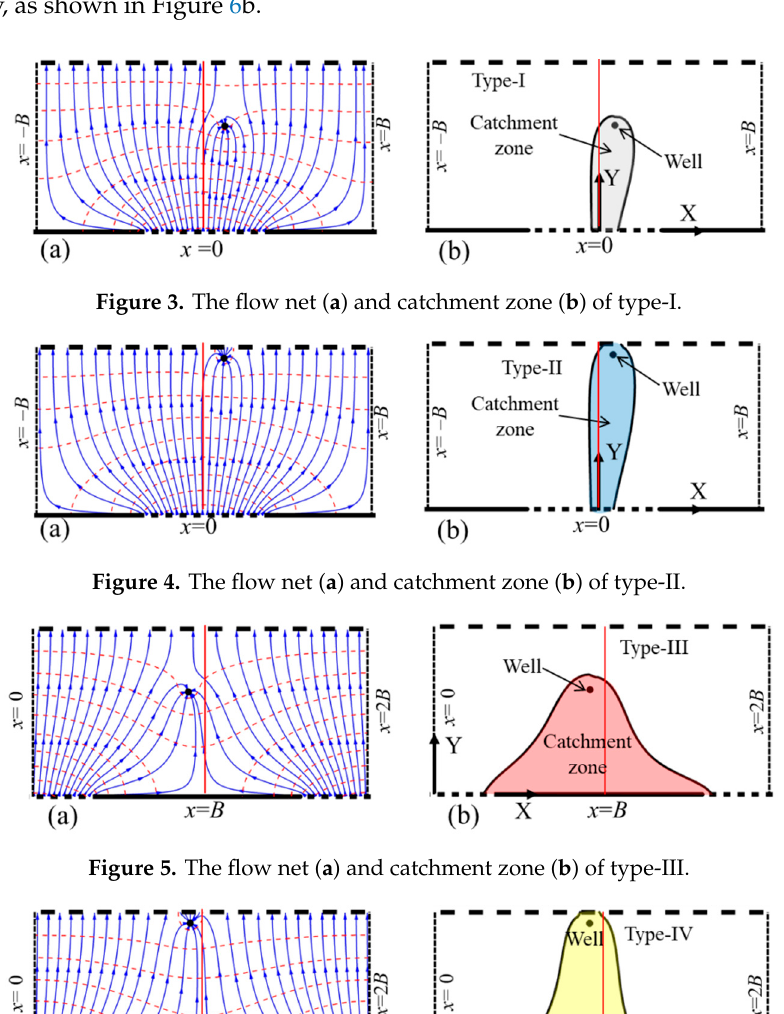
Figure 6. The flow net ( a ) and catchment zone ( b ) of type-IV.